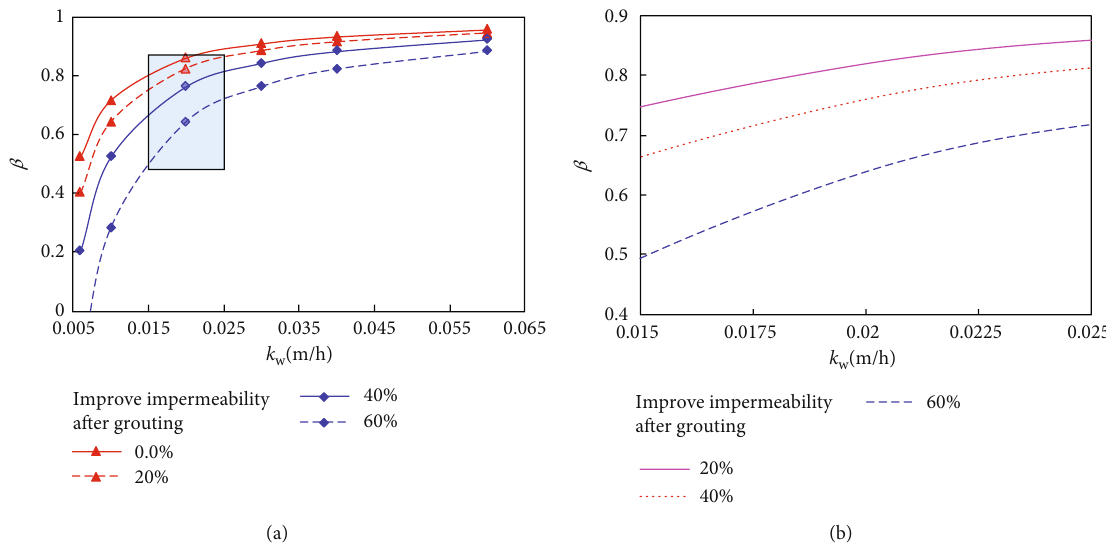
Figure 6: Relationship between water pressure reduction coe ffi cient and the initial permeability: (a) e ff ects of grouting; (b) enlargement of grouting e ff